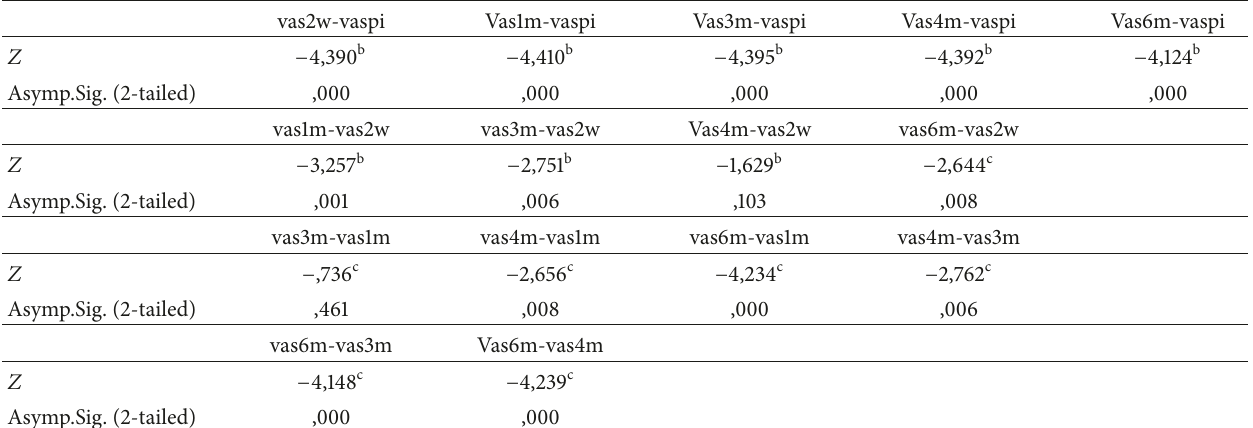
Table 4: Test statistics a . a Wilcoxon signed ranks test. b Based on positive ranks. c Based on negative